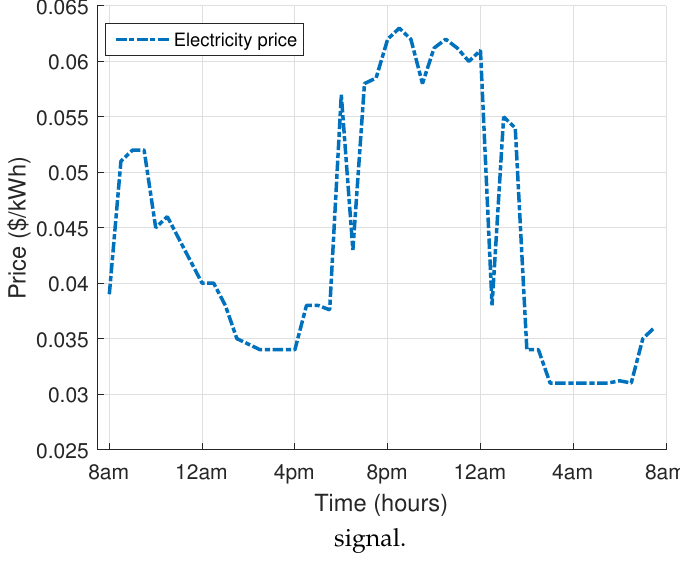
Figure 10. Real time porice